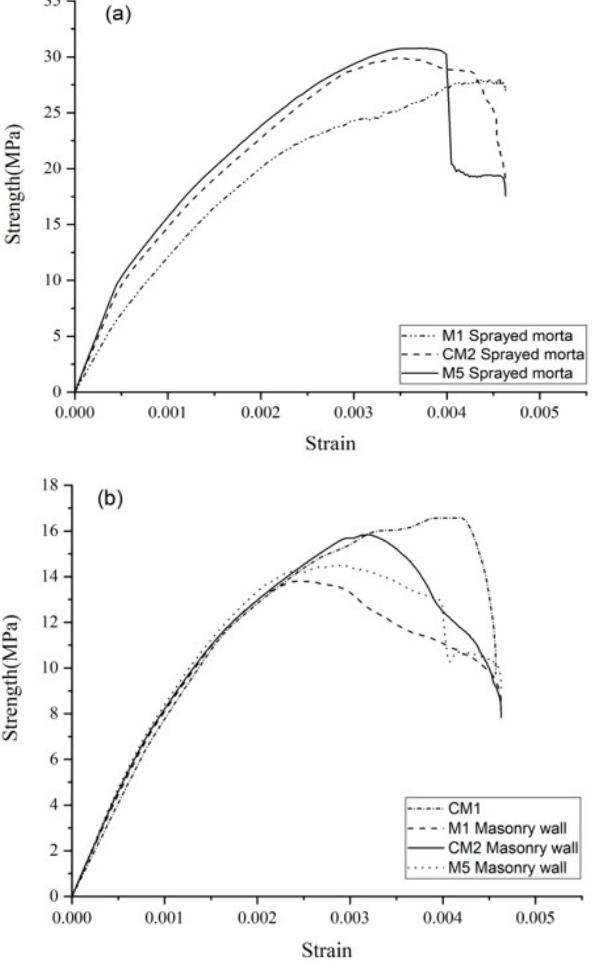
Figure 20. Comparison of stress-strain curve from FE numerical; ( a ) Sprayed layer- M1, CM2,M5 ( b ) Masonry